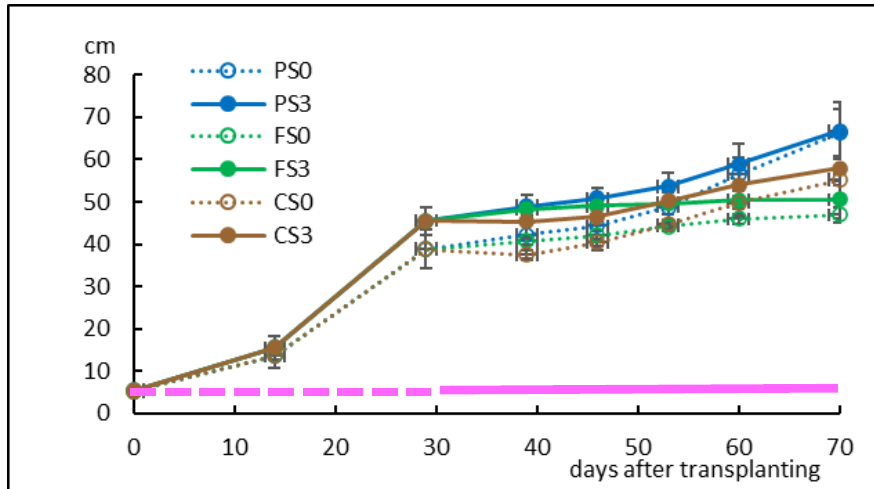
Figure 7. Shoot height of willow plantlets cultured for 4 weeks in the phytotron and for 6 weeks in the greenhouse in three types of soil. PS0, PS3: plants grown in peat and micropropagated without sucrose (PS0) or with 3% sucrose (PS3); FS0, FS3: plants grown in a forest soil and micropropagated without sucrose (FS0) or with 3% sucrose (FS3); CS0, CS3: plants grown in a crop soil and micropropagated without sucrose (CS0) or with 3% sucrose (CS3). Pink dashed line corresponds to the phytotron stage, and pink solid line corresponds to the greenhouse stage. Values are presented as means ± standard error of 14 plants (phytotron stage) and 4 plants (greenhouse stage) per treatment.